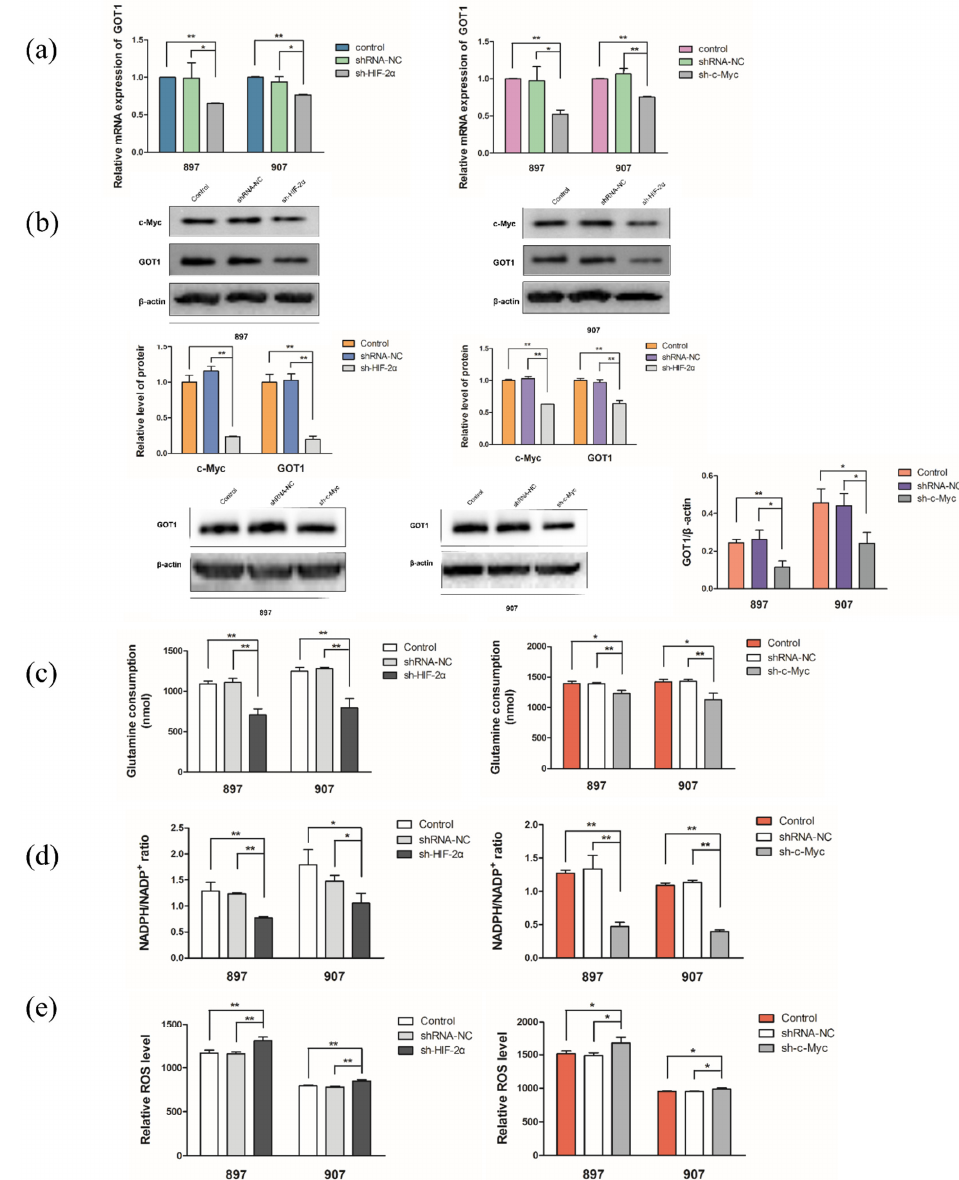
Figure 3. Kras G12D -LOH-activated HIF-2 α -c-Myc signaling regulates glutamine metabolism. ( a ) Relative mRNA expression of GOT1 in sh-HIF-2 α - or sh-c-Myc-transfected Kras G12D -LOH cells (897 and 907 cells) compared with that in the shRNA-NC and control groups. ( b ) Relative protein expression of GOT1 in sh-HIF-2 α - or sh-c-Myc-transfected Kras G12D -LOH cells (897 and 907 cells) compared with that in the shRNA-NC and control groups. ( c ) Glutamine consumption rate. ( d ) NADPH:NADP + ratio. ( e ) Reactive oxygen species (ROS) levels. Data are expressed as the mean ± SD, based on three independent experiments. * p < 0.05; ** p < 0.01.